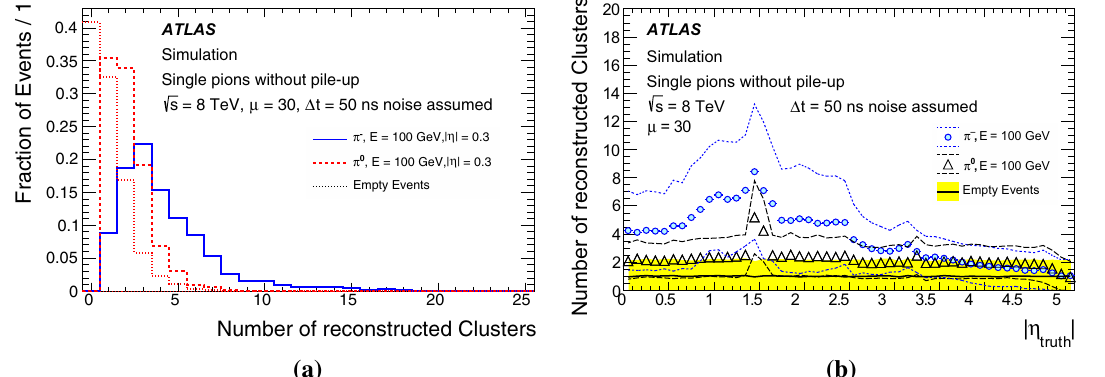
Fig. 7 The number of reconstructed clusters for simulated charged and neutral single pions without actual pile-up added but with nom- inal pile-up noise used in the reconstruction. In a the distribution of the number of clusters N clus is shown for neutral and charged pions injected into the ATLAS calorimeters at | η | = 0 . 3 with an energy of E = 100GeV, together with the N clus distribution for empty events